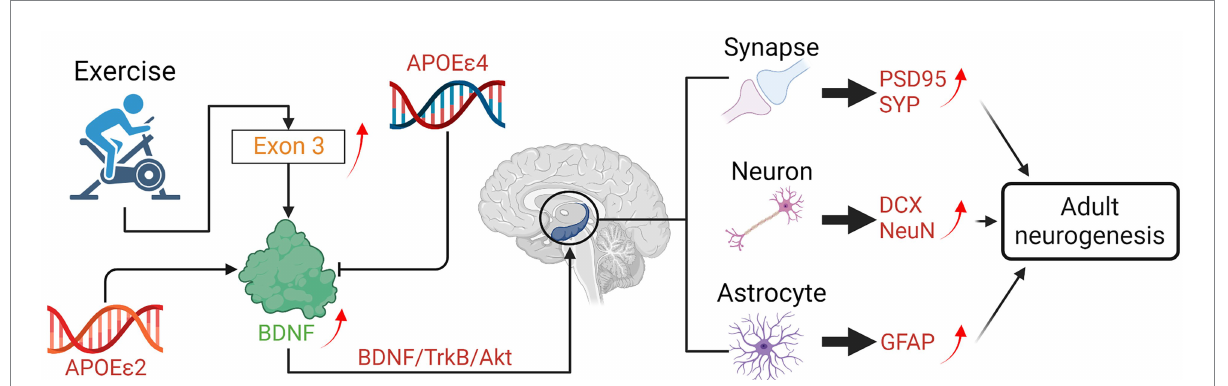
FIGURE 3 Effects of exercise on the neurogenesis mediated by BDNF in neurodegenerative